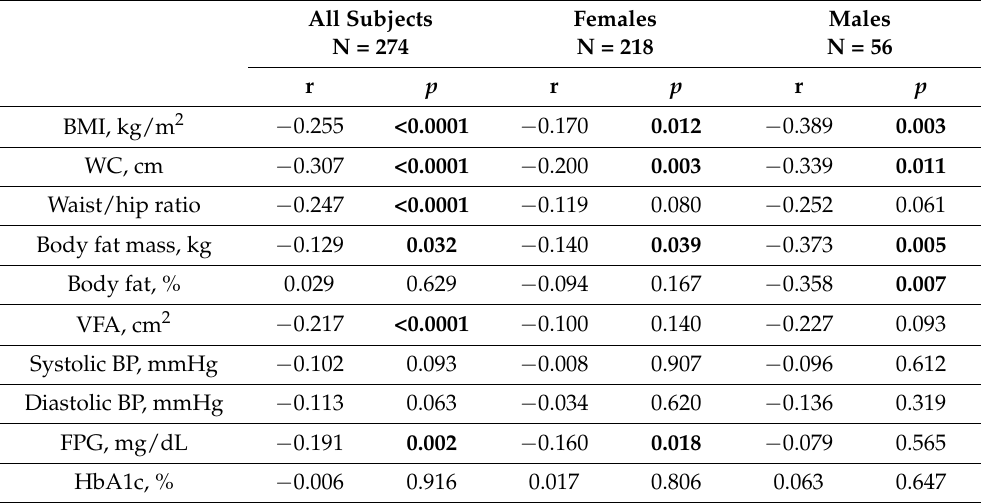
Table 2. Correlations between adiponectin levels and parameters reflecting MetS components or lipid